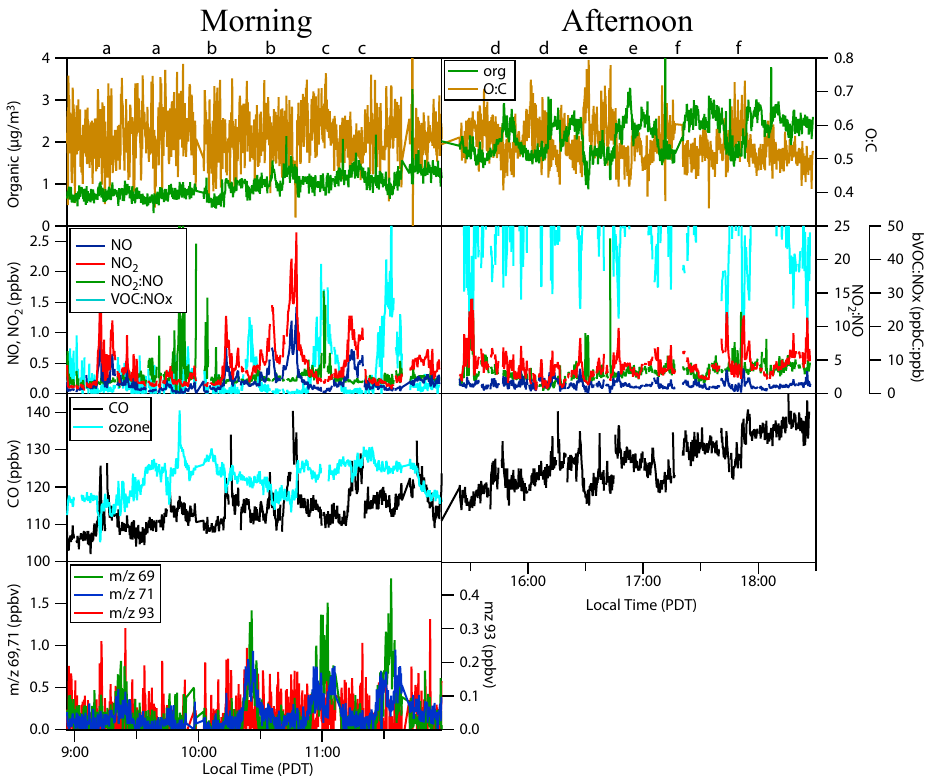
Fig. 10. Organic particle mass, organic particle O:C, CO, ozone, NO, NO 2 , NO 2 :NO, bVOC:NO x , m / z 69 (isoprene), m / z 71 (MVK+MACR), and m / z 93 (toluene) concentrations for the morning and afternoon 12 June flights. Note there is a break in the time axis. PTR-MS and ozone measurements were not available during the afternoon flights. Letters at the top of the graph correspond to the flight legs labeled in Fig.